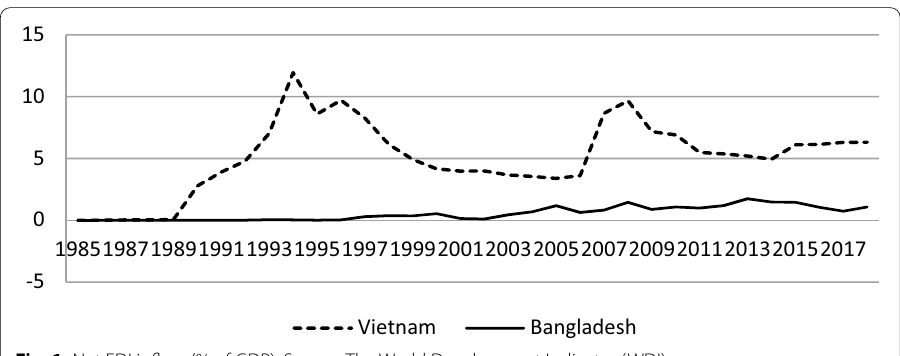
Fig. 1 Net FDI inflow (% of GDP). Source: The World Development Indicator